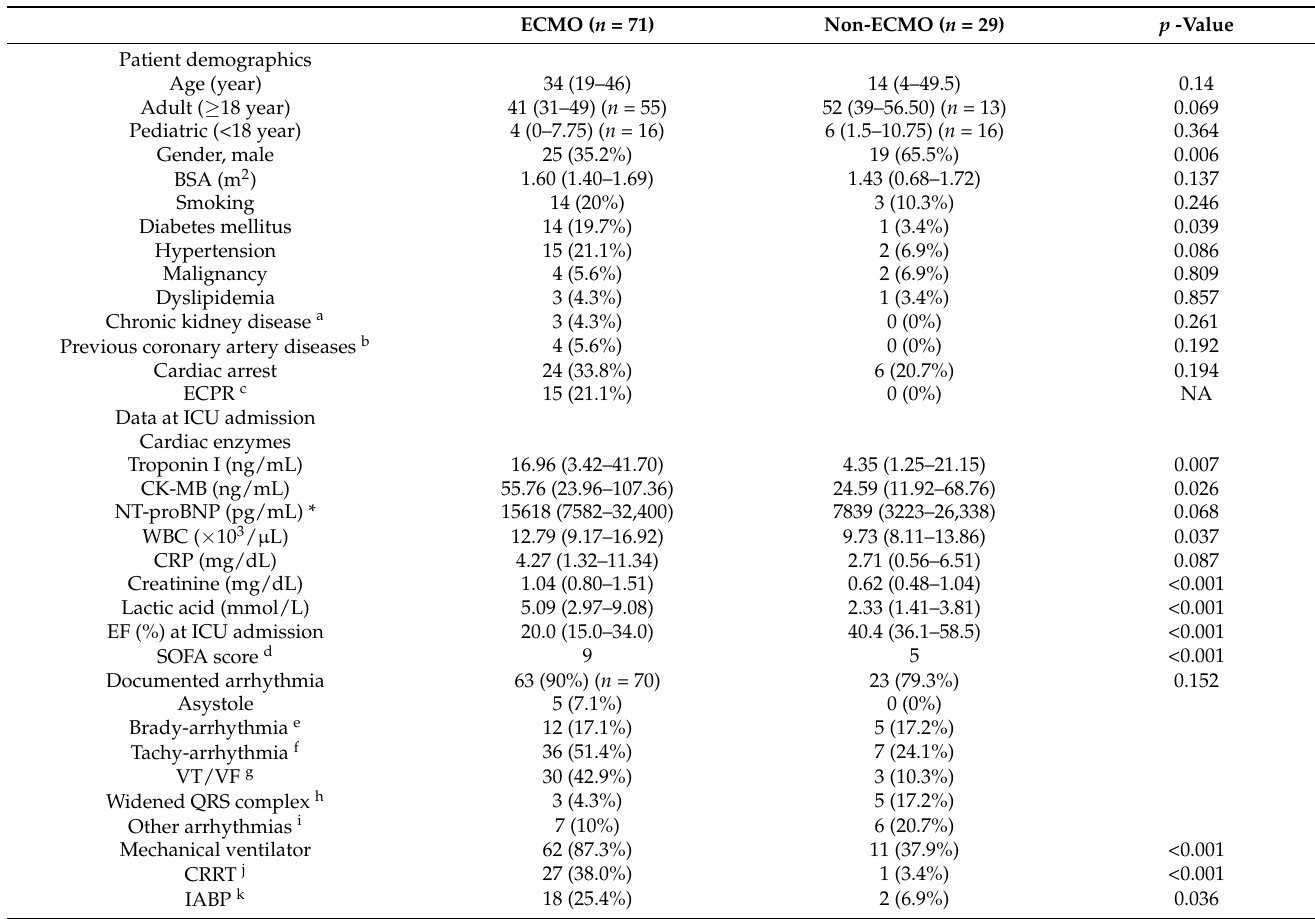
Table 1. Baseline characteristics of the